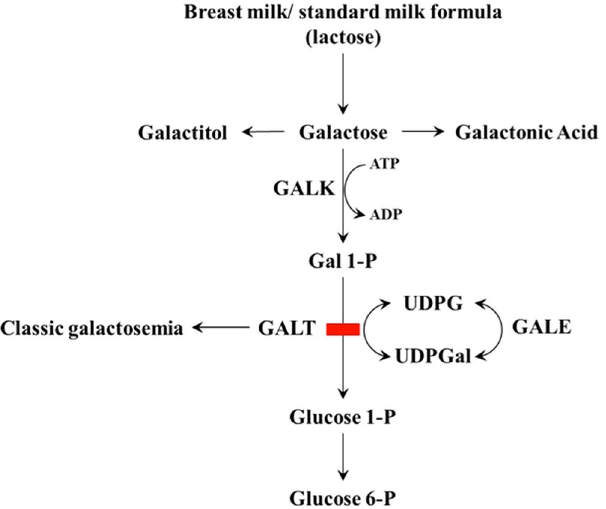
Figure 1. The Leloir pathway of galactose metabolism. GALT, Galactose 1-phosphate uridyltransferase; GALE, UDP-galactose 4 ′ -epimerase; GALK, Galactokinase; UDPGal, UDP-galactose; UDPG, UDP-glucose; Gal-1-P, Galactose 1-phosphate; Glucose-1-P, Glucose-1-phosphate; Glucose-6-P,